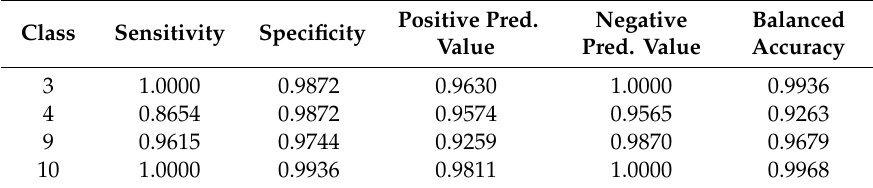
Table 12. Statistics by class for zones 3, 4, 9 and